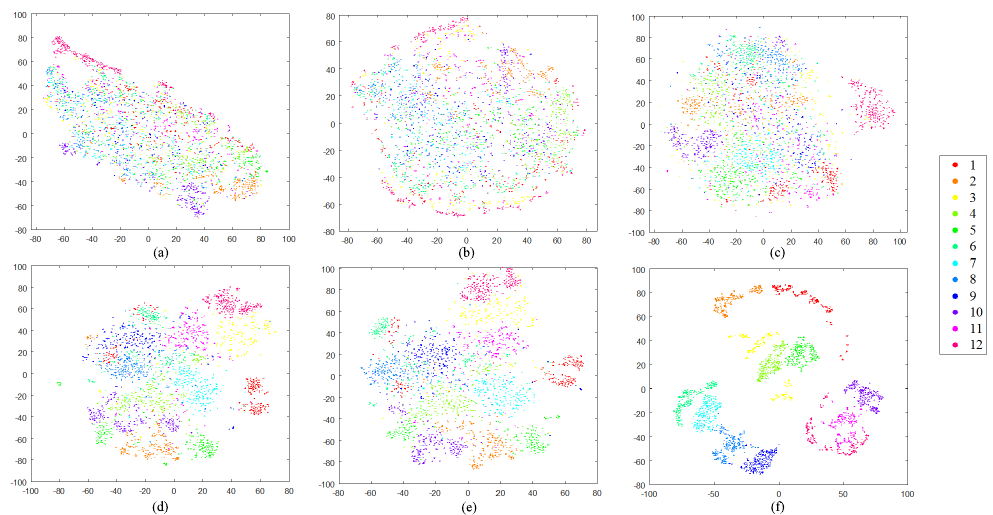
Figure 15. Two-dimensional scatterplots of different high-dimensional features obtained by t-SNE over ImgDB3 with 12 semantic classes. The relationships between number ID and semantics can be found in Figure 11. ( a ) HT; ( b ) CH; ( c ) S-BOW; ( d ) DN-7; ( e ) DN-8; ( f ) DBOW.